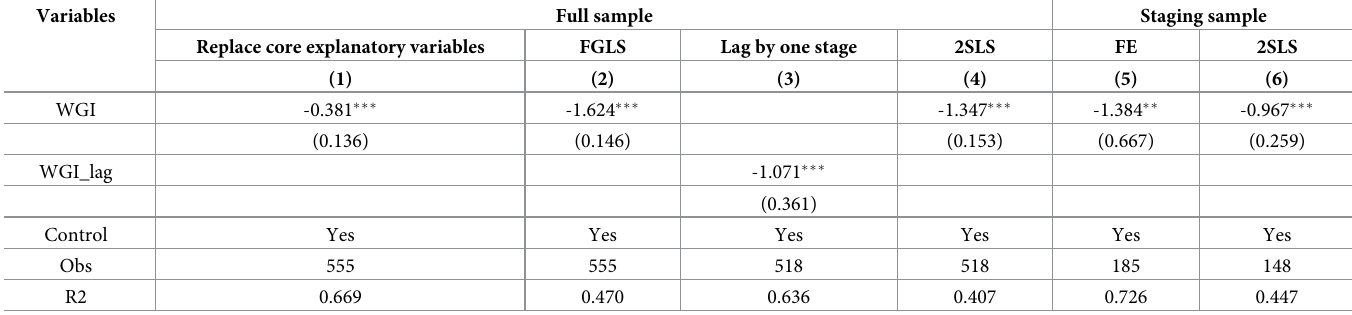
Table 4. Robustness test estimation